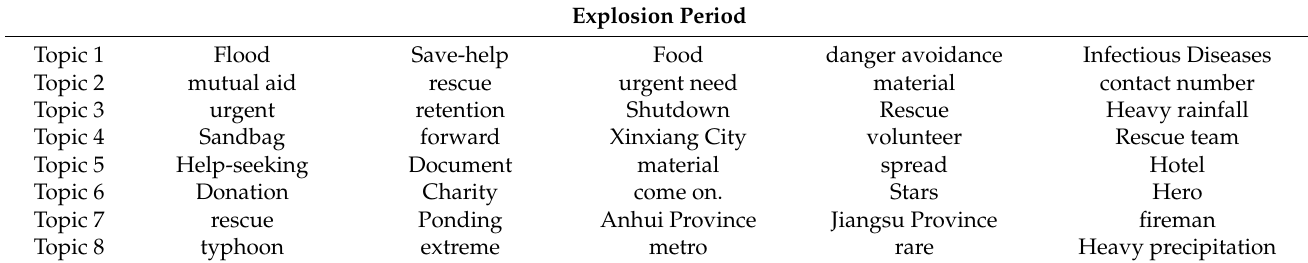
Table 2. Text topic extraction results in the explosion